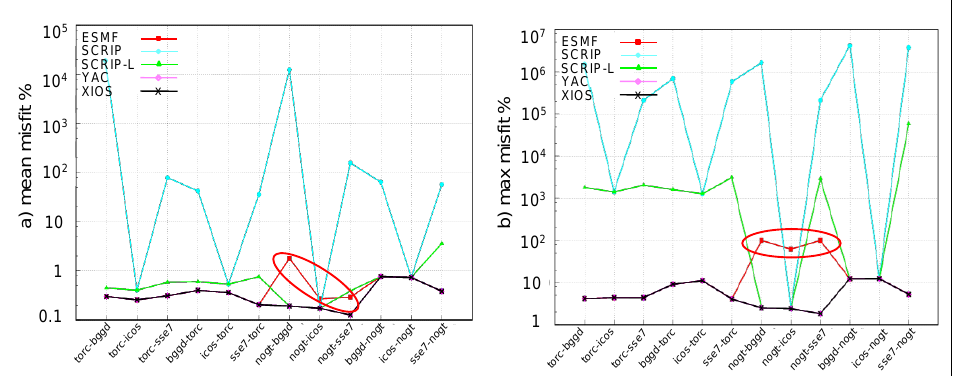
Figure 11. ( a ) Mean and ( b ) maximum misfit for ESMF, SCRIP, SCRIP-L, YAC, and XIOS for the first-order conservative remapping with DESTAREA normalisation for the different pairs of grids for the harmonic function. For ESMF, nogt and torc are described with the SCRIP structured format. The red oval shapes identify ESMF regriddings showing anomalous mean and maximum misfits when nogt is the source grid. These regriddings are discussed in the text.